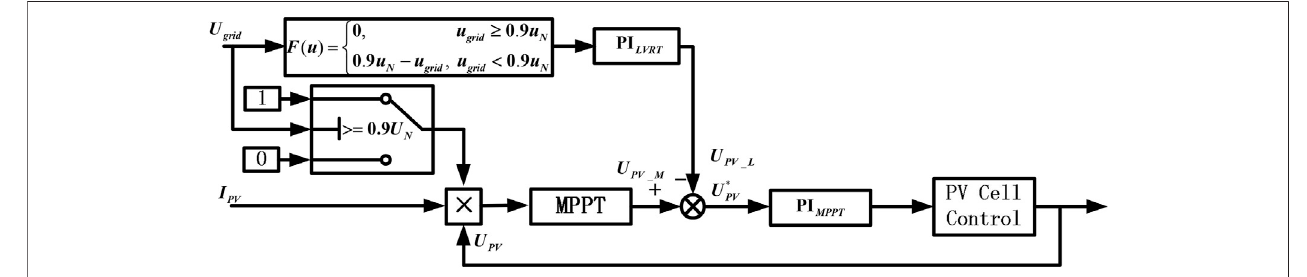
FIGURE 4 | Control block diagram of the control switch